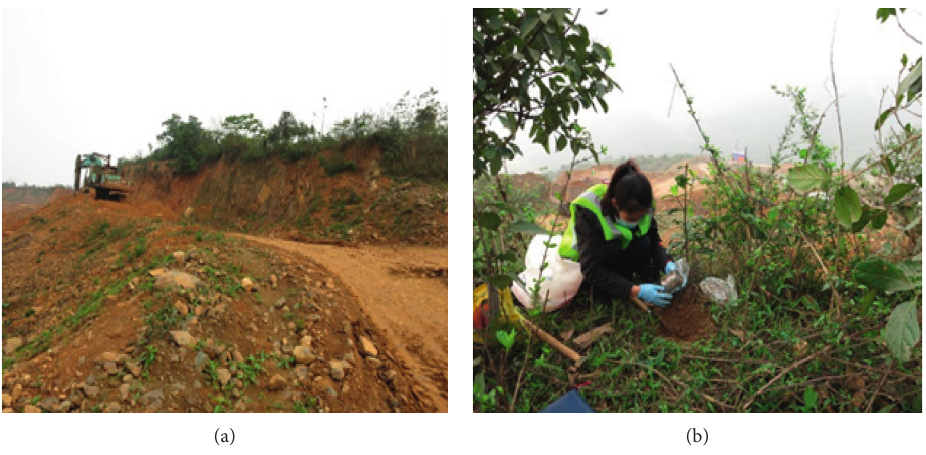
Figure 2: Sampling point in mining site (basalt